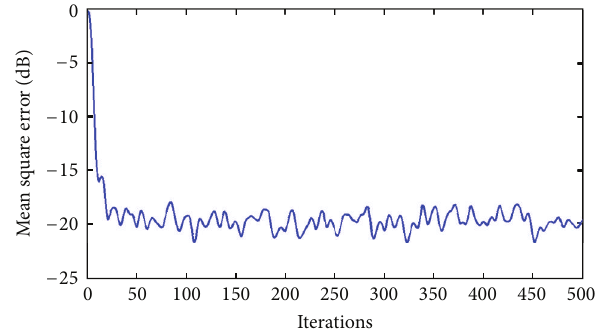
Figure 7: Optimized value of joint cost function of PSMA, PCMA, and